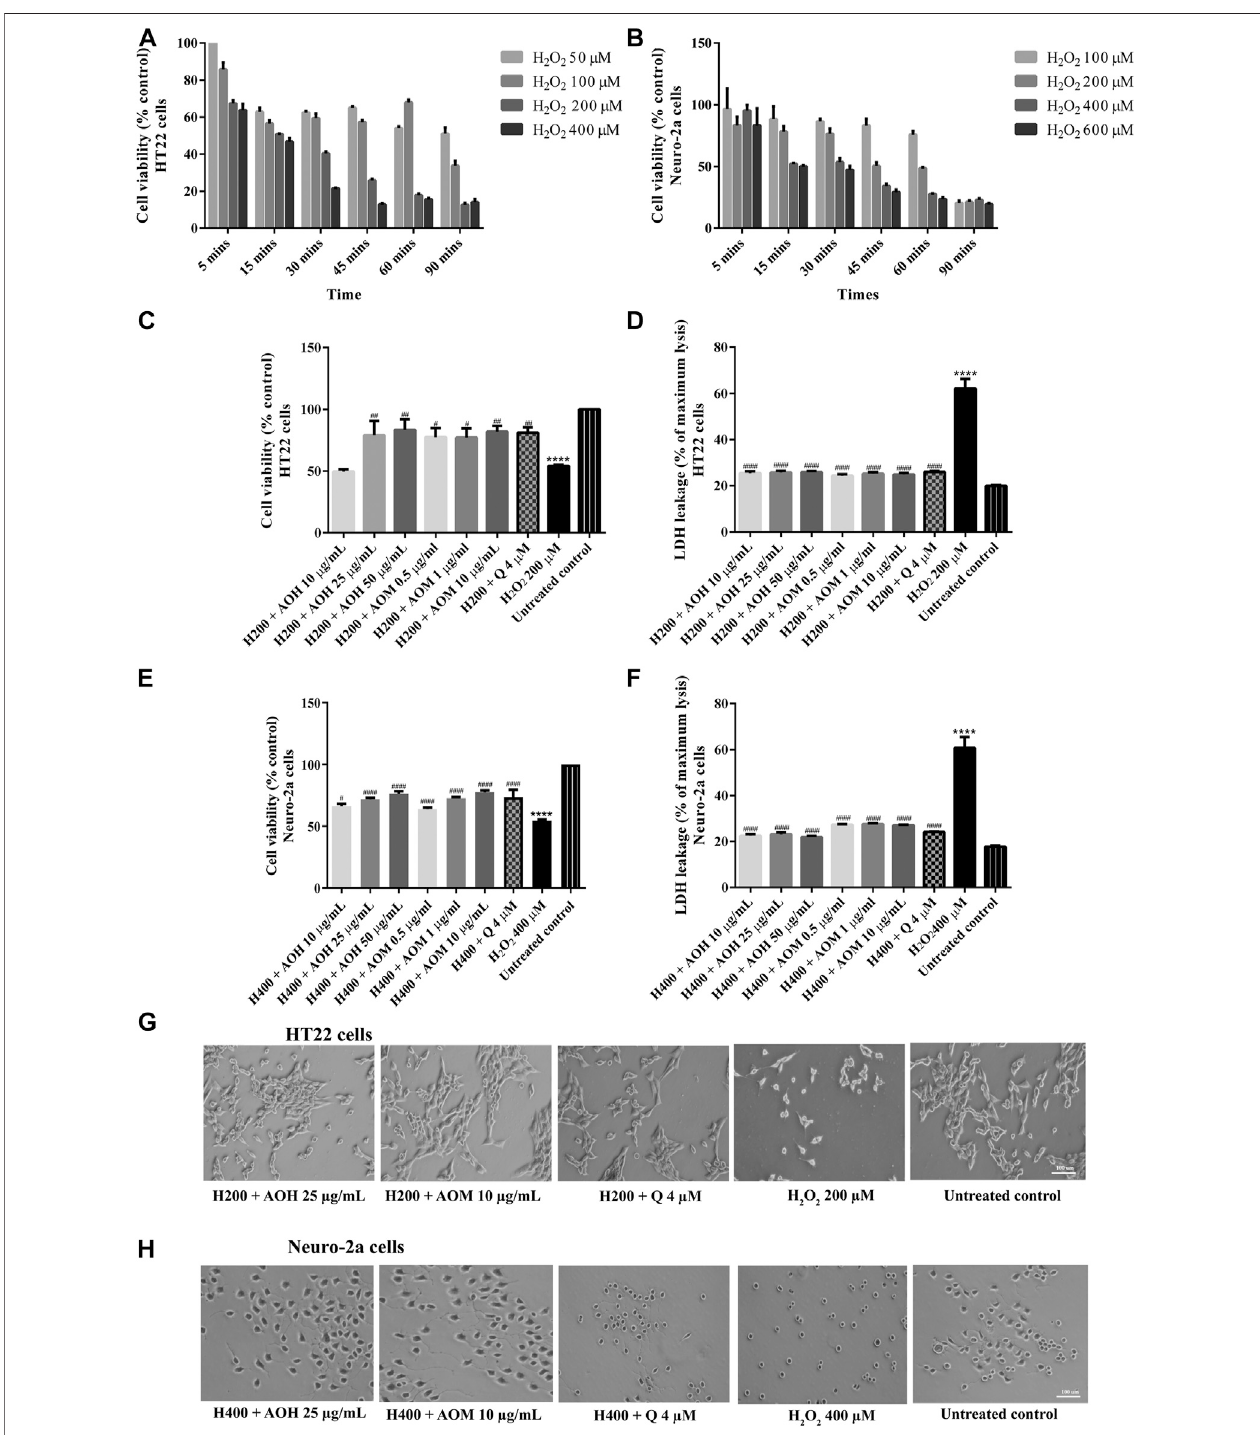
FIGURE 3 | Protective effects of AO extracts on H 2 O 2 -induced toxicity in HT22 and Neuro-2a cells. Cells were exposed to various concentrations of H 2 O 2 for different times in HT22 (A) and Neuro-2a cells, cell viability was measured by MTT assay (B) . Cell viability of HT22 (C,D) and Neuro-2a cells (E,F) , cell morphology of HT22 (G) andNeuro-2a (H) aftertreatmentwithdifferentconcentrationsofAOextracts. Cellmorphologywasobservedundermicroscopeat5 × magni fi cation. Samples weretreatedwithAOextractsfor48 handexposedtoH 2 O 2 (H200:200 µMH 2 O 2 ,H400:400 µMH 2 O 2 )for15 mintoinducetoxicity.Theresultsareexpressedas the means ± SEM of independent experiments ( n (cid:1) 3). **** p < 0.0001 compared to the untreated control; # p < 0.05, ## p < 0.01, ### p < 0.001 and #### p < 0.0001, compared to the group exposed to H 2 O 2